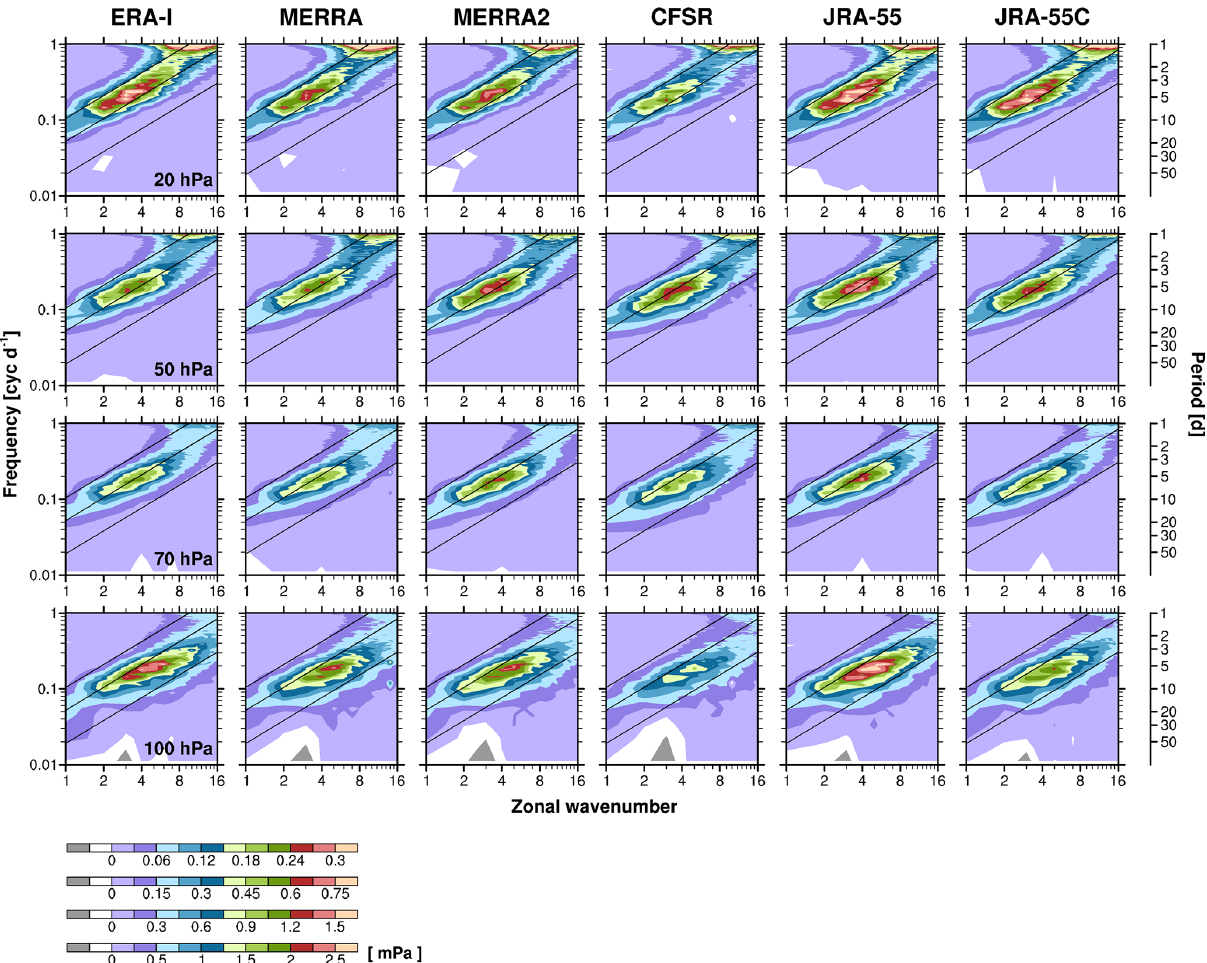
Figure 9. Zonal wavenumber–frequency spectra of the vertical EP flux, multiplied by − 1 ( − F z ), for symmetric modes at 100, 70, 50, and 20hPa (from bottom to top) from the standard-level datasets of six reanalyses, averaged over 5 ◦ N–5 ◦ S in 1981–2010. The Kelvin wave dispersion curves are indicated by black diagonal lines for h = 8, 60, and